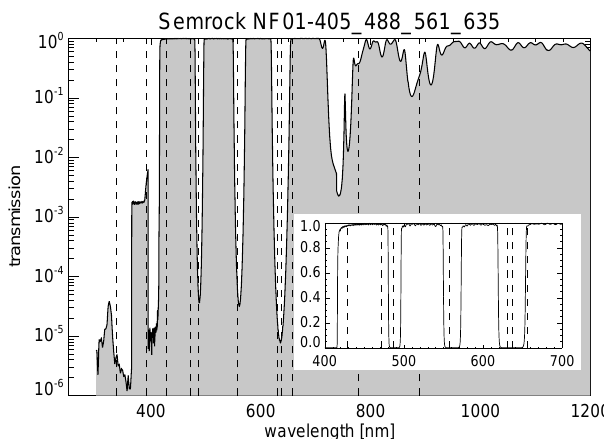
Figure 18. Spectral transmission for a Semrock NF01- 405/488/561/635 multinotch filter with rejection bands near 405, 488, 561, and 635nm. Vertical dashed lines correspond to some typ- ical auroral emission wavelengths.